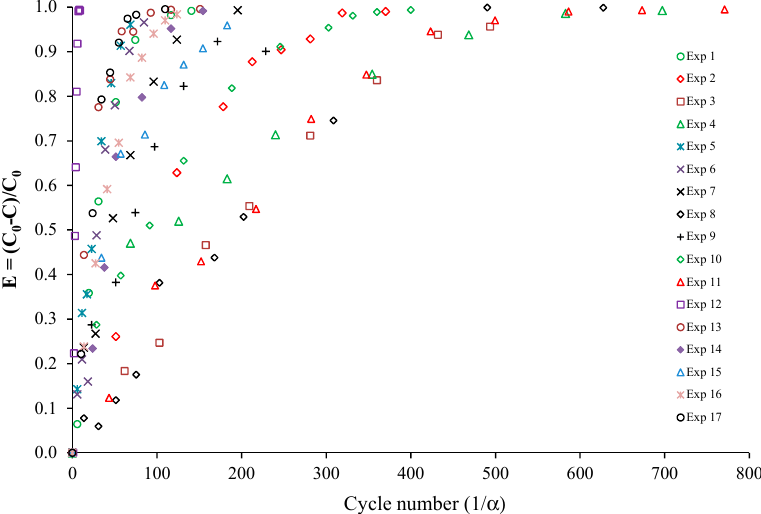
Figure 5. Toluene removal efficiency for all experiments as a function of the number of cycles in the closed-loop reactor.